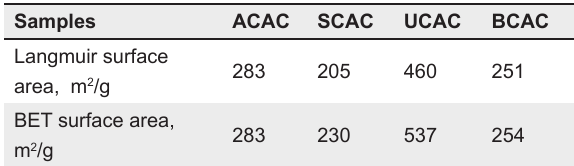
Table 5. BET and Langmuir surface area of AC